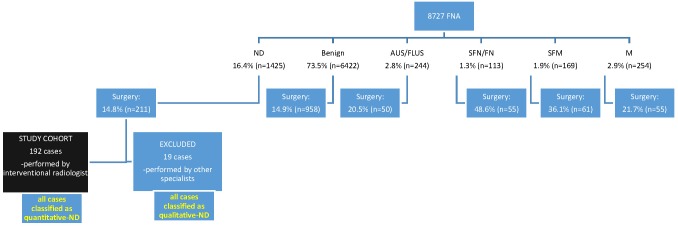
Distribution of FNA cases during the study period.